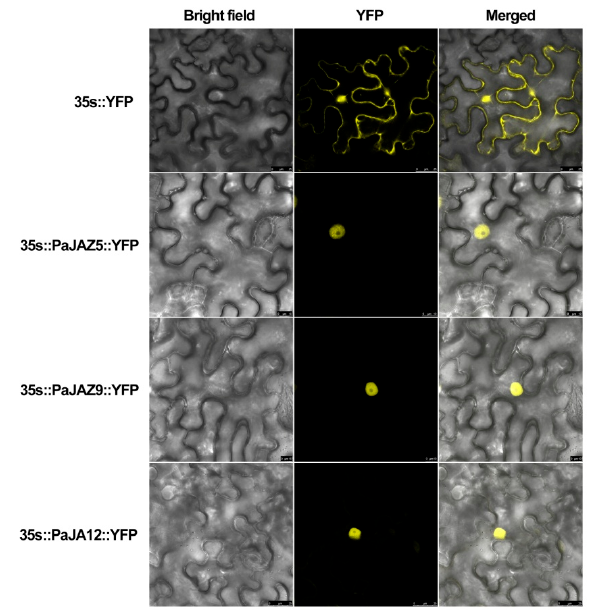
Figure 7. Subcellular localization assays of PaJA5, PaJAZ9, and PaJAZ12 proteins in tobacco leaf cells; 35s::YFP was used as the positive control.